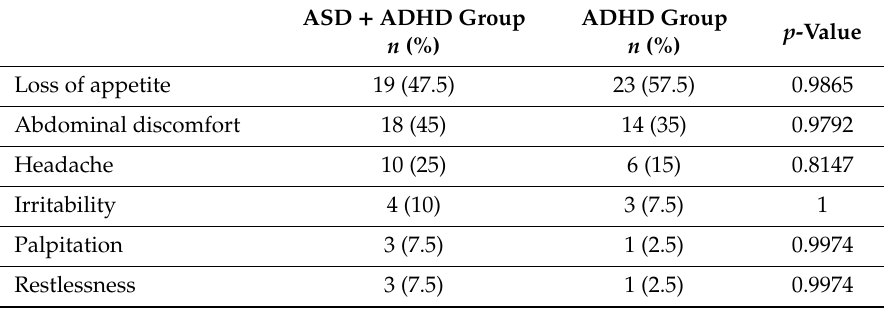
Table 5. Side e ff